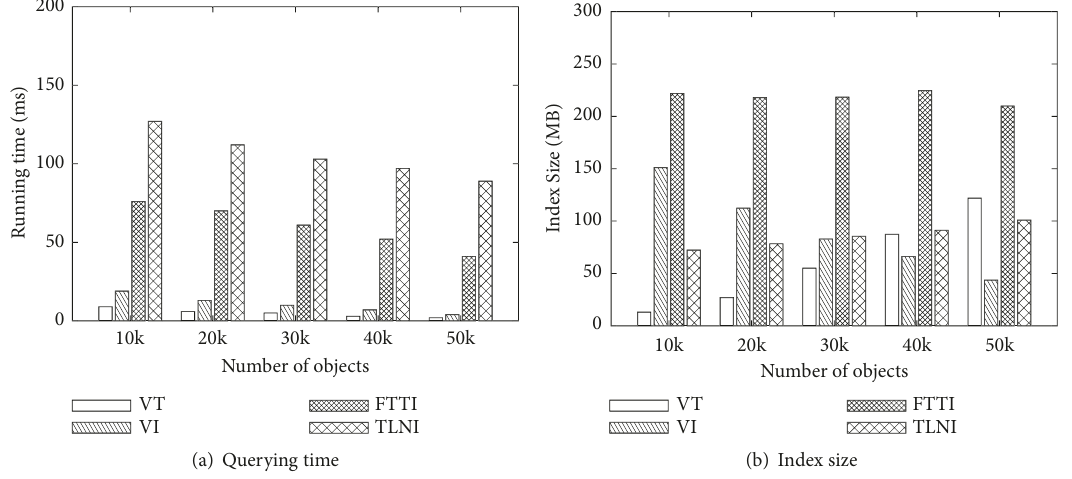
Figure 6: Impact of the object set